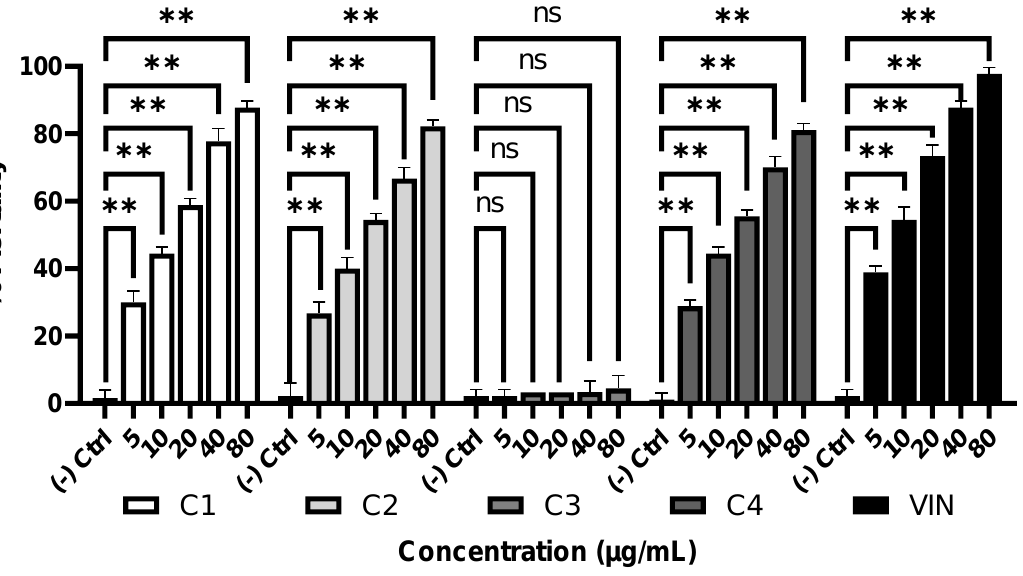
Figure 2. Cytotoxicity of the compounds 1 - 4 . ( A ) Percent mortality at different concentration of the compounds; ( B ) LC 50 (µg/mL). 1 , 12.42 ± 0.87; 2 , 16.17 ± 1.11; 4 , 14.27 ± 0.87; Vincristine, 3.48 ± 0.36. Data are represented as mean ± SD (n = 3). ** p < 0.01, significant difference compared with the control group. 1 , (-) kaur- 16α -hydroxy-19-oic acid; 2 , (-) kaur-16-en-19-oic acid; 3 , β -sitosterol; 4 , cholesta-5,23-dien-3-ol; VIN, vincristine; ns, not significant.